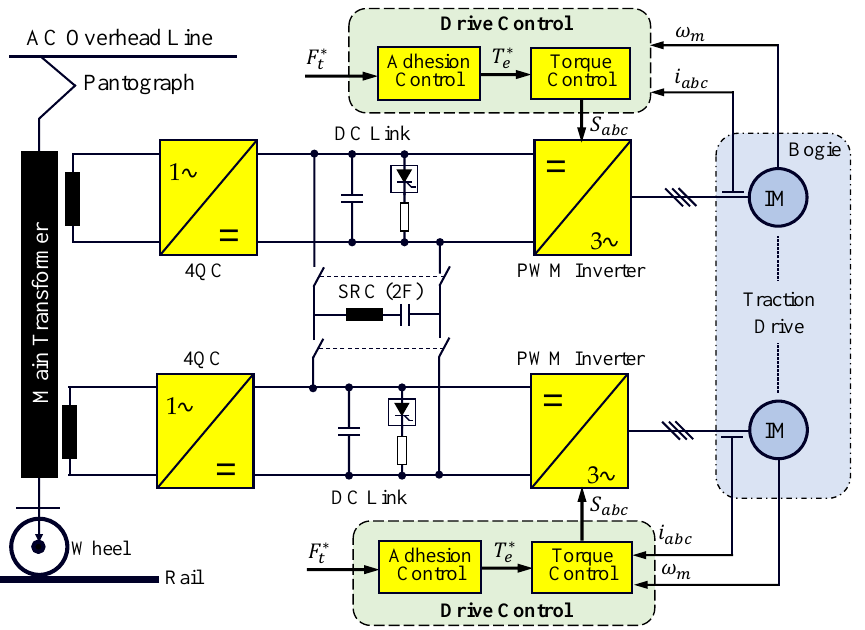
Figure 1. Main circuit elements of a high-performance locomotive